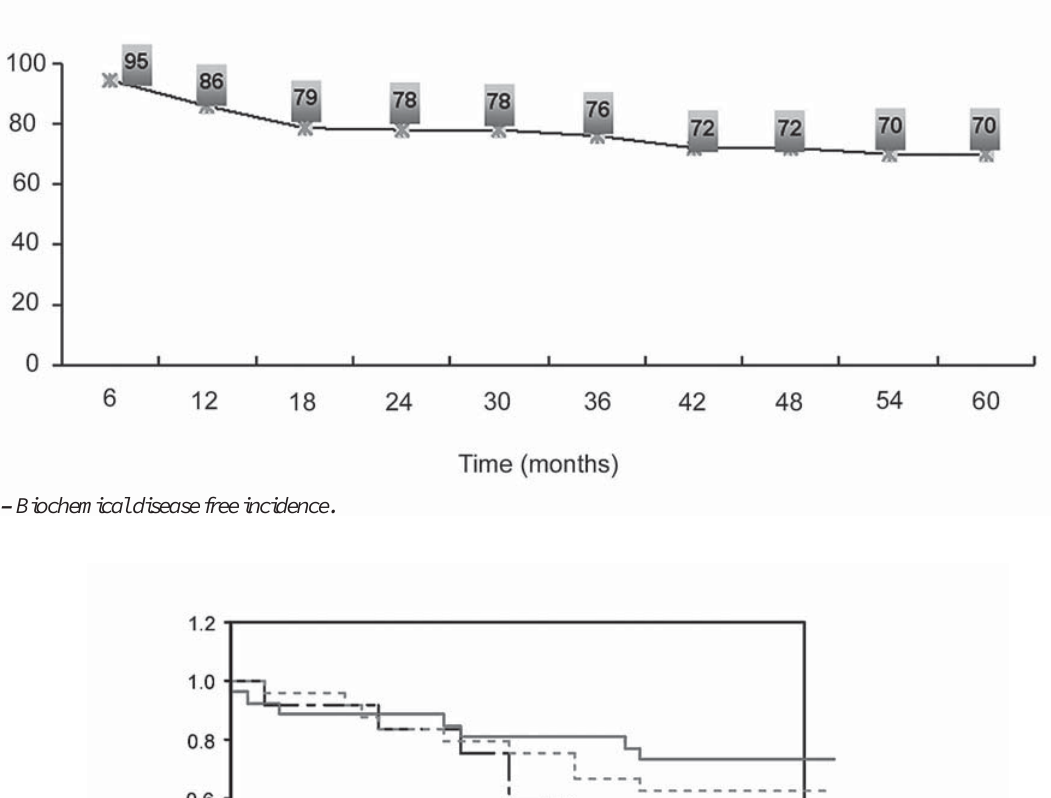
Figure 1 – Biochemical disease free incidence.